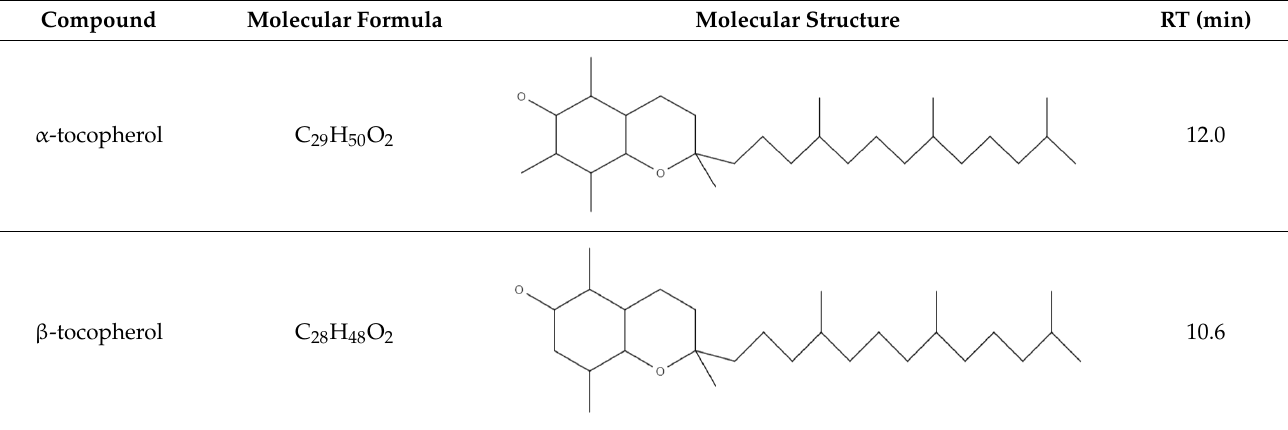
Figure 1. Characteristic chromatogram of a standard mixture of tocopherols ( α -tocopherol: 5 mg/kg; ( β + γ )-tocopherol: 5 mg/kg; δ -tocopherol: 5 mg/kg) monitored at 295 nm. Table 4. Molecular formulas, molecular structures, and retention times.